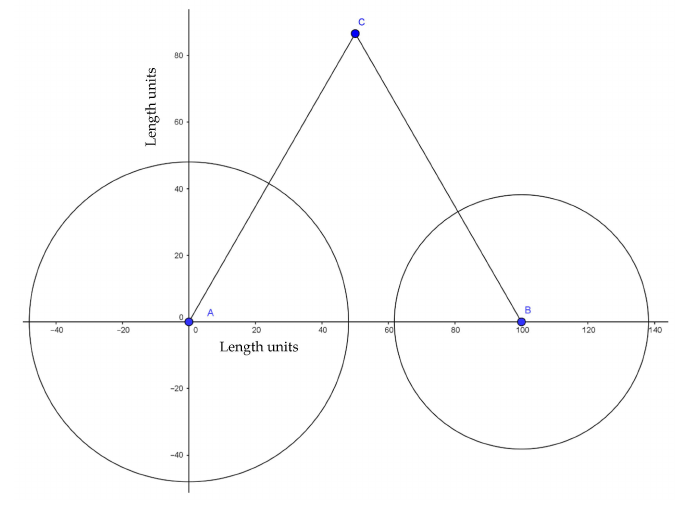
Figure 9. Initial conditions to locate the source of the acoustic